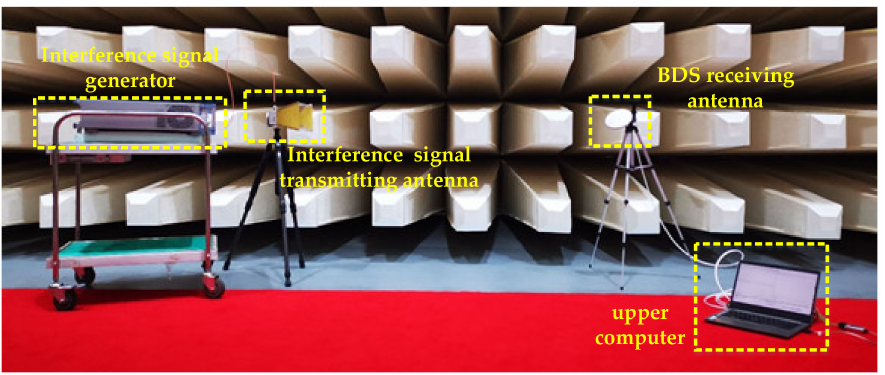
Figure 15. Experiment layout for EMC evaluation of